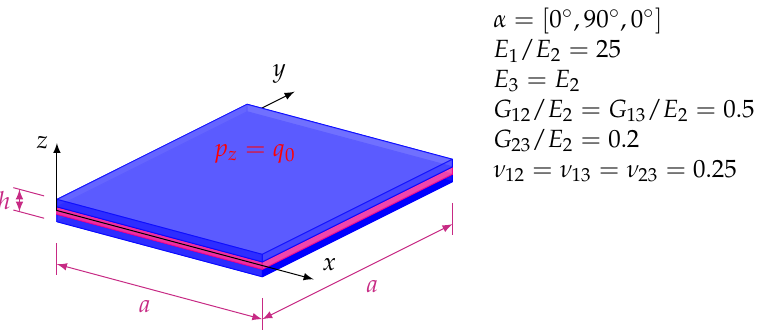
Figure 2. Example 1: Three-layered, simply supported sandwich plate loaded by constant distribution of transverse pressure.